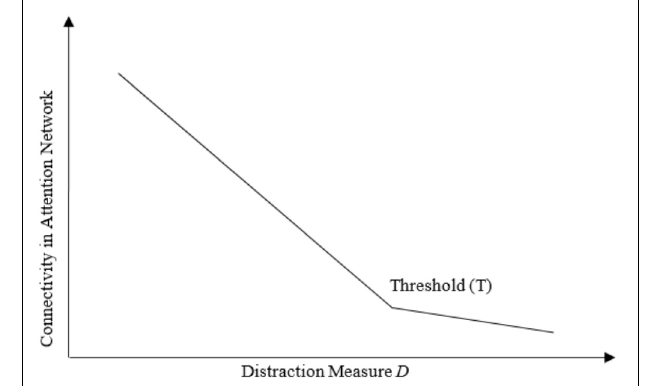
FIGURE 1 | Relationship between Connectivity and Distraction. Hypothesized relationship between connectivity in attentional networks and distraction from a primary